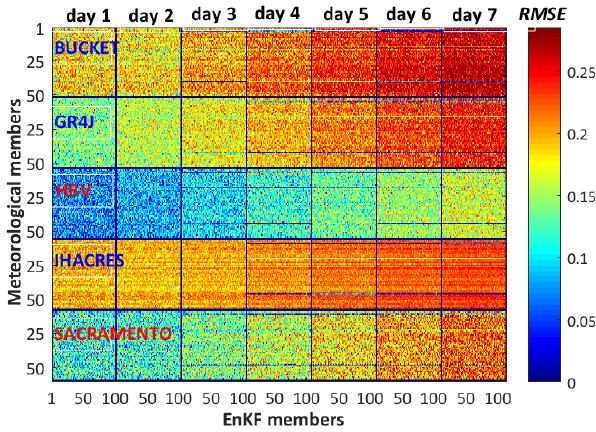
Figure 4. Illustration of the RMSE values (mmd − 1 ) of the indi- vidual members of the forecast issued by the five H-EPSs for the Baskatong sub-catchment on day 500. There are seven daily fore- cast horizons. Each box consists of 5000 members, including 100 EnKF members (horizontal lines) and 50 meteorological members (vertical lines).